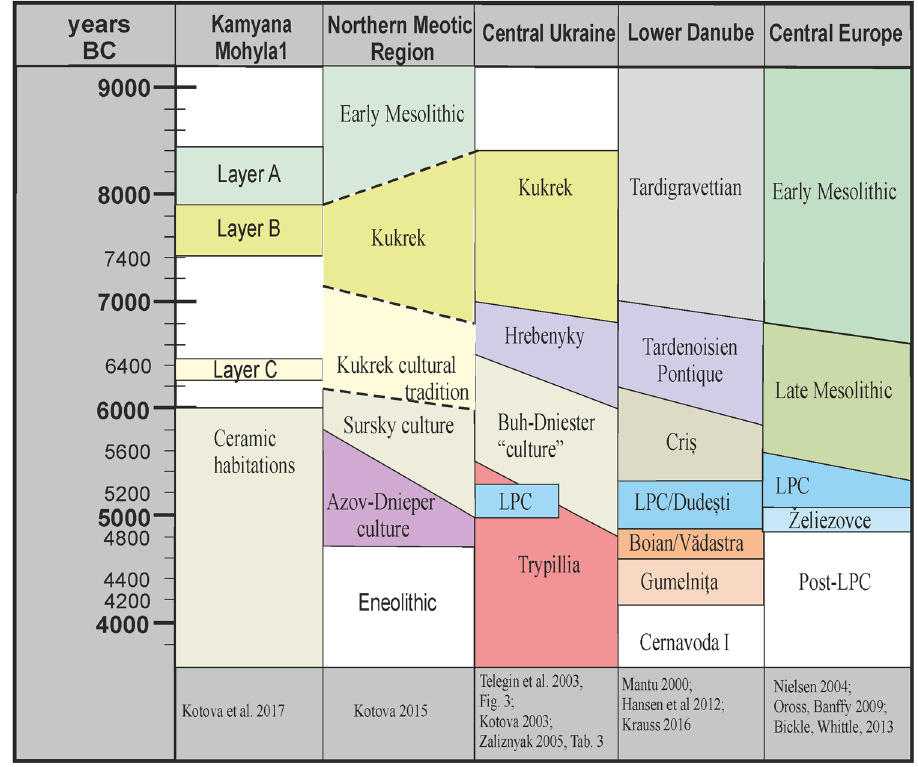
Figure 14: Chronological table for the Kamyana Mohyla 1 site in the context. Dotted line indicates uncertainty in the chron - ological position of the indicated